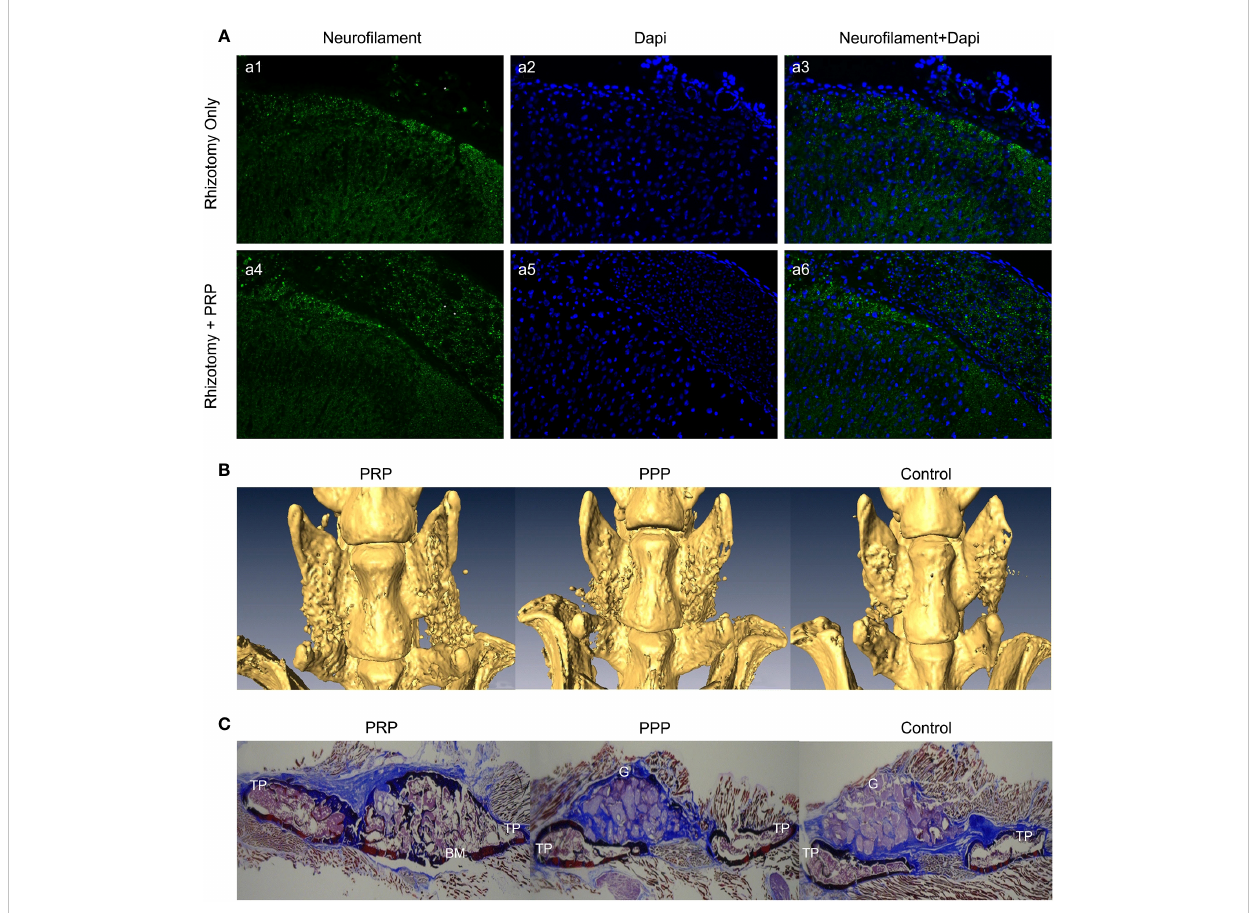
FIGURE 4 (A) Immuno fl uorescence analysis of neuro fi lament in the spinal cord dorsal horn and roots 8 weeks following dorsal rhizotomy and repair. (a1-a3) The Rhizotomy Only group showed obvious dorsal root degeneration. (a4-a6) Rhizotomy + PRP group showed obvious dorsal root repair. Degenerated dorsal roots are indicated by (*), and repaired dorsal roots are indicated by (**). (B) Microscopic CT scans of each group. PRP group had better fusion quality between transverse processes. (C) Masson ’ s trichrome staining showed more new bone formation in the PRP group with mature fusion masses between transverse processes. TP transverse process, BM bone marrow, G granules of mineral carrier. Reproduced with permission from (79,